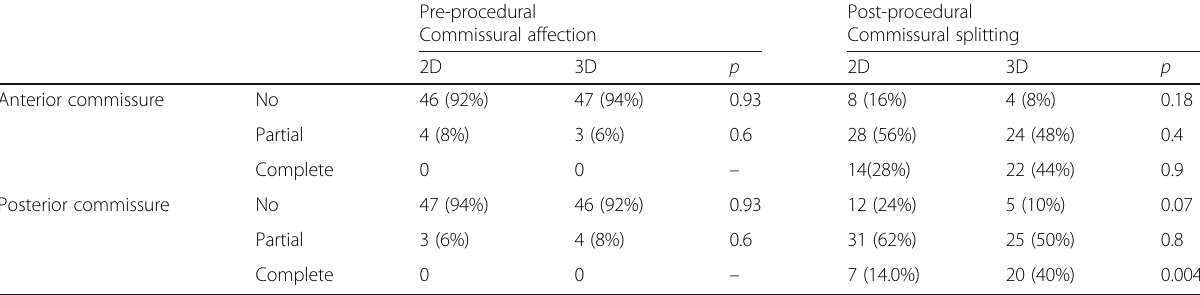
Table 3 Pre-procedural commissural affection and post-procedural commissural splitting as estimated by 2D and 3D echocardiography Pre-procedural Commissural